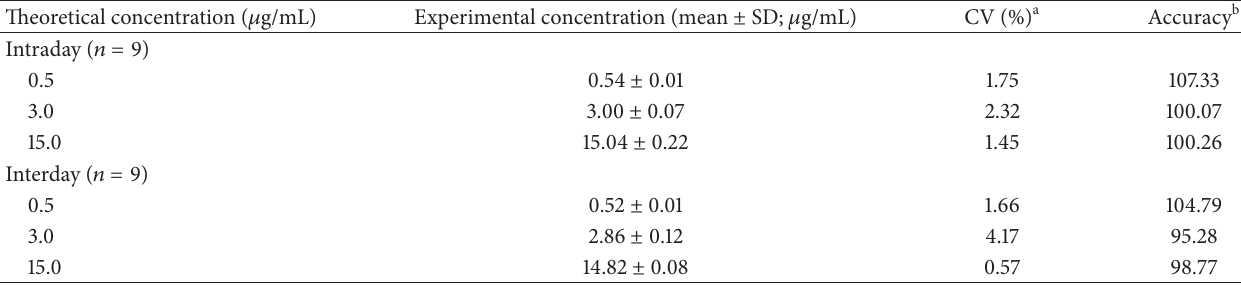
Table 2: Precision (CV) and accuracy of the HPLC method for OXPt quantification.